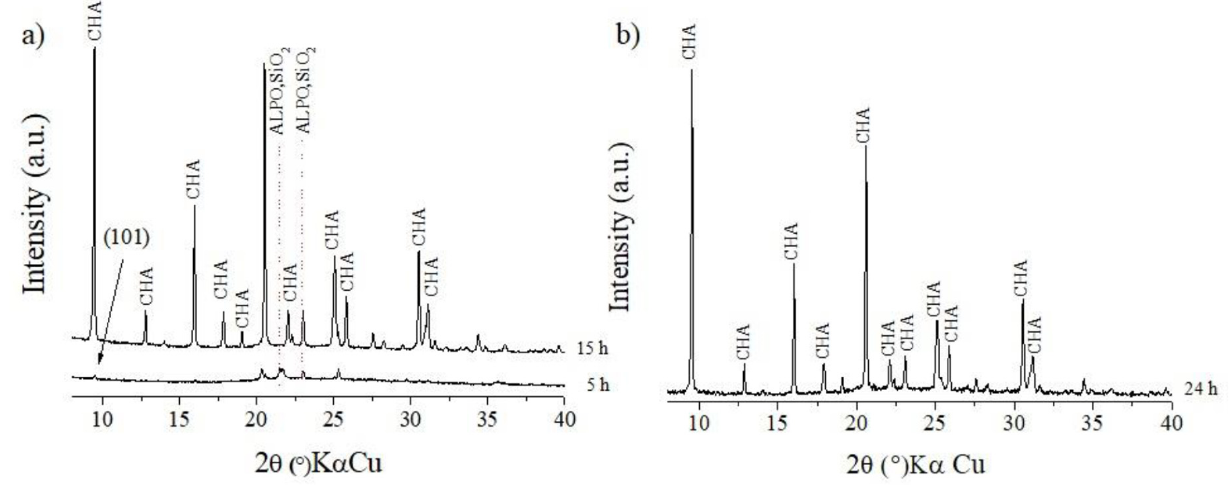
Figure 4. x = 2: ( a ) crystallization time = 5 and 15 h; ( b ) crystallization time = 24 h. In contrast, for x = 1 and x = 2 (Figures 3 and 4), the increase in the amount of morpholine significantly increased the formation of the CHA structure in a shorter amount of time, whereas the peaks of tridymite evidenced for x = 0.5 were absent at 15 h ( x = 1 and x = 2). This observation is related to the positive effect of SDA on the SM2 and SM3 substitution mechanisms. Studies show that an increase in SDA in the synthesis promotes favorable conditions not only with the function of directing the structure, but also with importance in the distribution of silicon in the structure